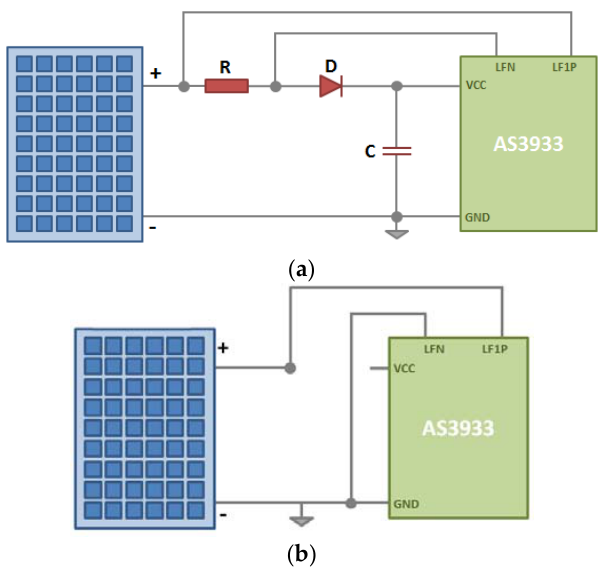
Figure 8. Two possible wake-up receiver circuit design options: ( a ) WuRx design 1 and ( b ) simplified WuRx design 2.